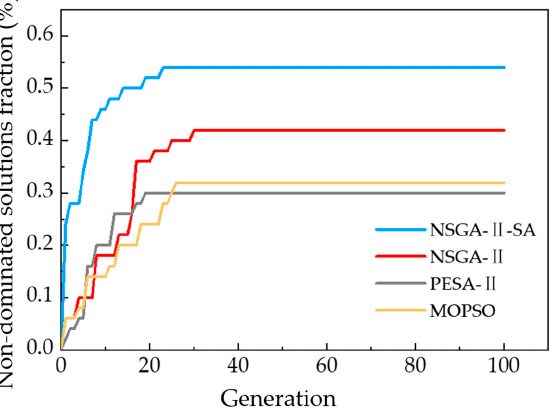
Figure 8. Time evolution diagram of the proportion of non-dominated solutions.